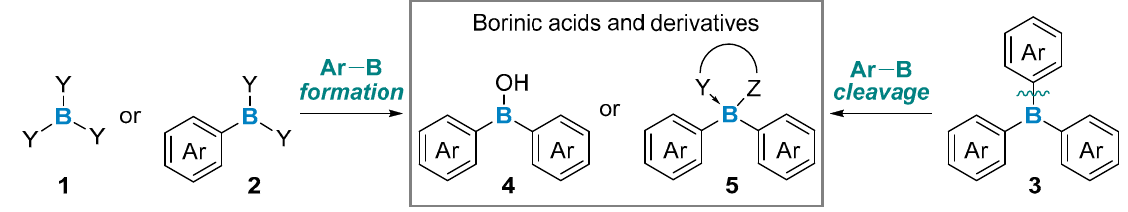
Figure 1. General methods for the synthesis of borinic acids 4 and their derivatives 5 .